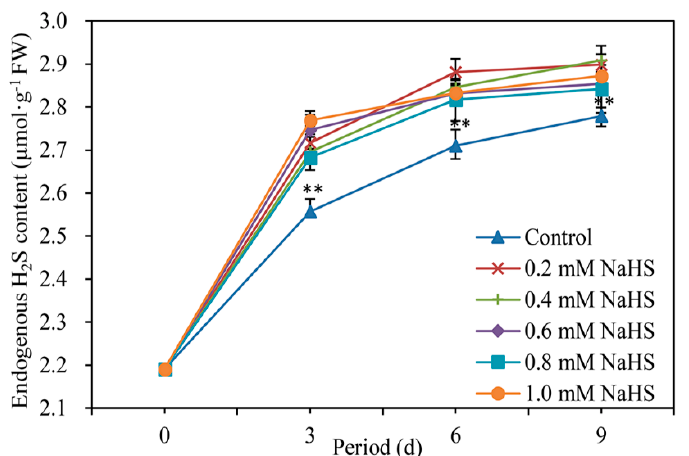
Figure 2. Effects of different concentrations of NaHS treatments on the endogenous H 2 S content in Lanzhou lily scales during storage at room temperature for 9 days. The concentrations of NaHS were 0, 0.2, 0.4, 0.6, 0.8, and 1 mM. The error bars denote the standard errors ( n = 3). The asterisks denote Duncan’s multiple range test for significance: ** p < 0.01. d: days.